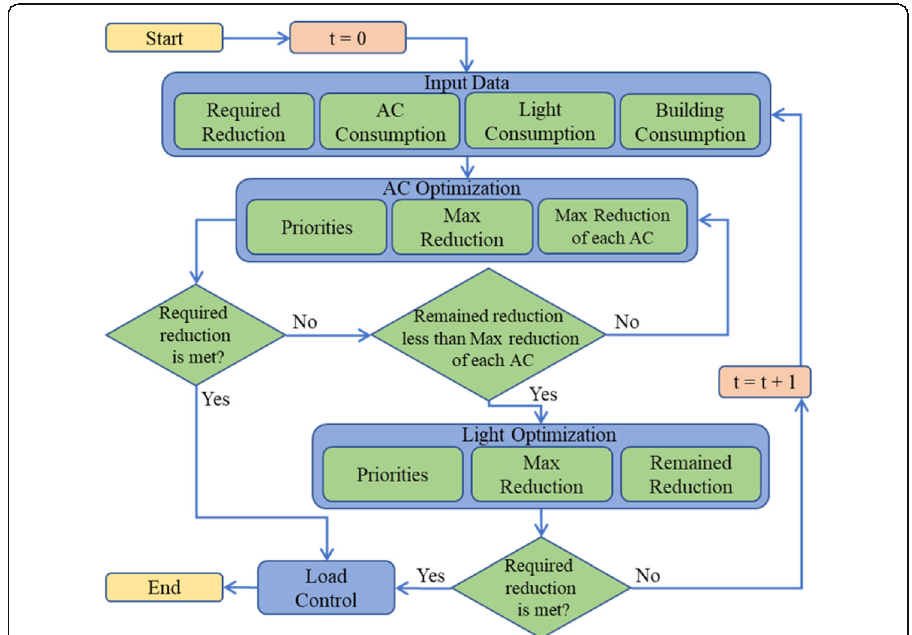
Fig. 4 Flowchart of the proposed optimization